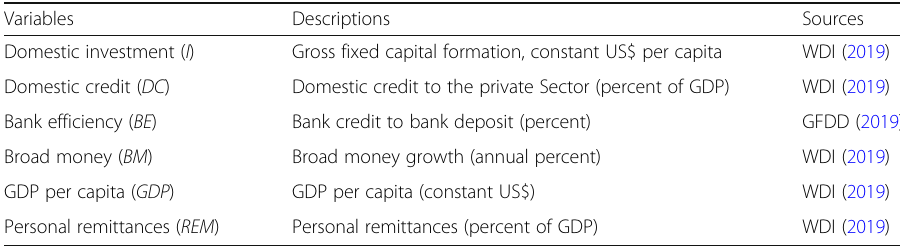
Table 1 Variables, descriptions and sources Variables